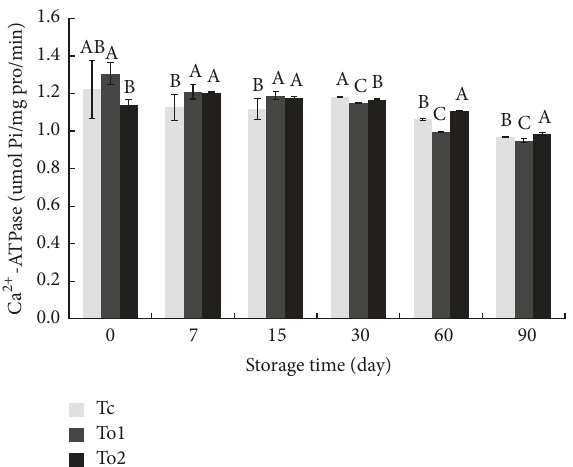
Figure 3: Changes in surface hydrophobicity of myofibrillar pro- teins extracted from silver carp surimi during frozen storage. Light grey: two washing cycles using ice water only (Tc), dark grey: first and second washing cycle using ice water containing 8 mg/L ozone and ice water, respectively (To1); black: first and second washingcycleusingicewaterandicewatercontaining8 mg/Lozone, respectively (To2). Different letters indicate significant difference among samples (Tc, To1, and